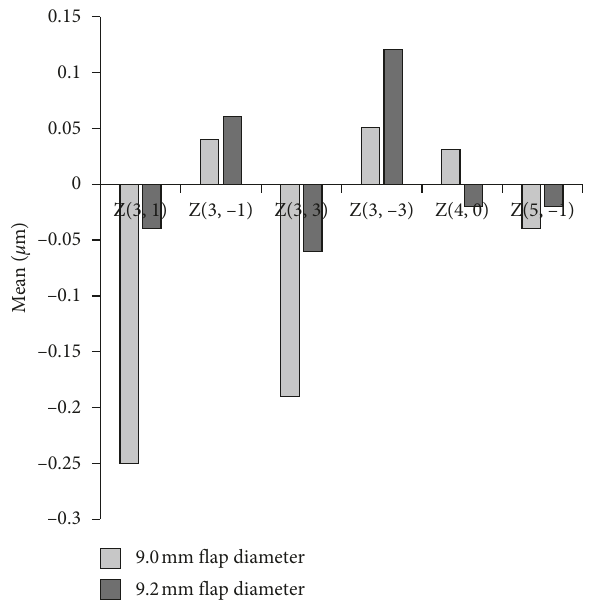
Figure 2: The similarity of the high order aberrations of the 9.0 and 9.2mm diameter flap groups. Z (3, 1): horizontal coma; Z (3, − 1): vertical coma; Z (3, 3): horizontal trefoil; Z (3, − 3): vertical trefoil; Z (4, 0): spherical aberration; and Z (5, − 1): second order vertical